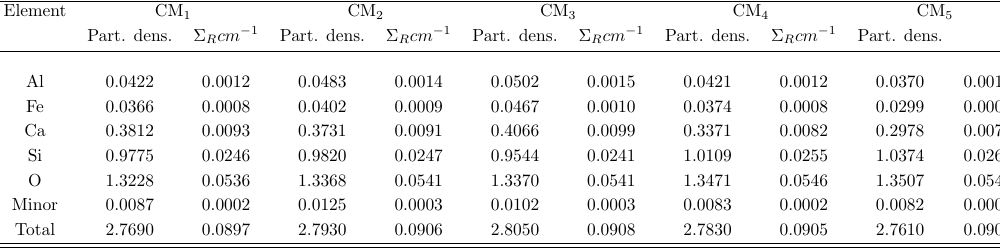
Table 2: Calculations of the fast neutron removal cross-section for the prepared samples. Element CM 1 CM 2 CM 3 CM 4 Al